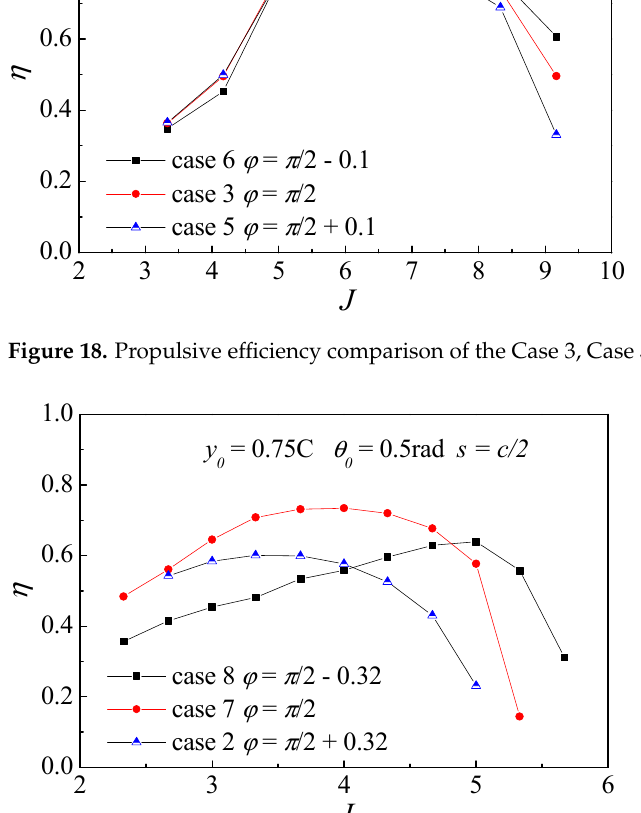
Figure 19. Propulsive efficiency comparison of the Case 2, Case 7 and Case 8.